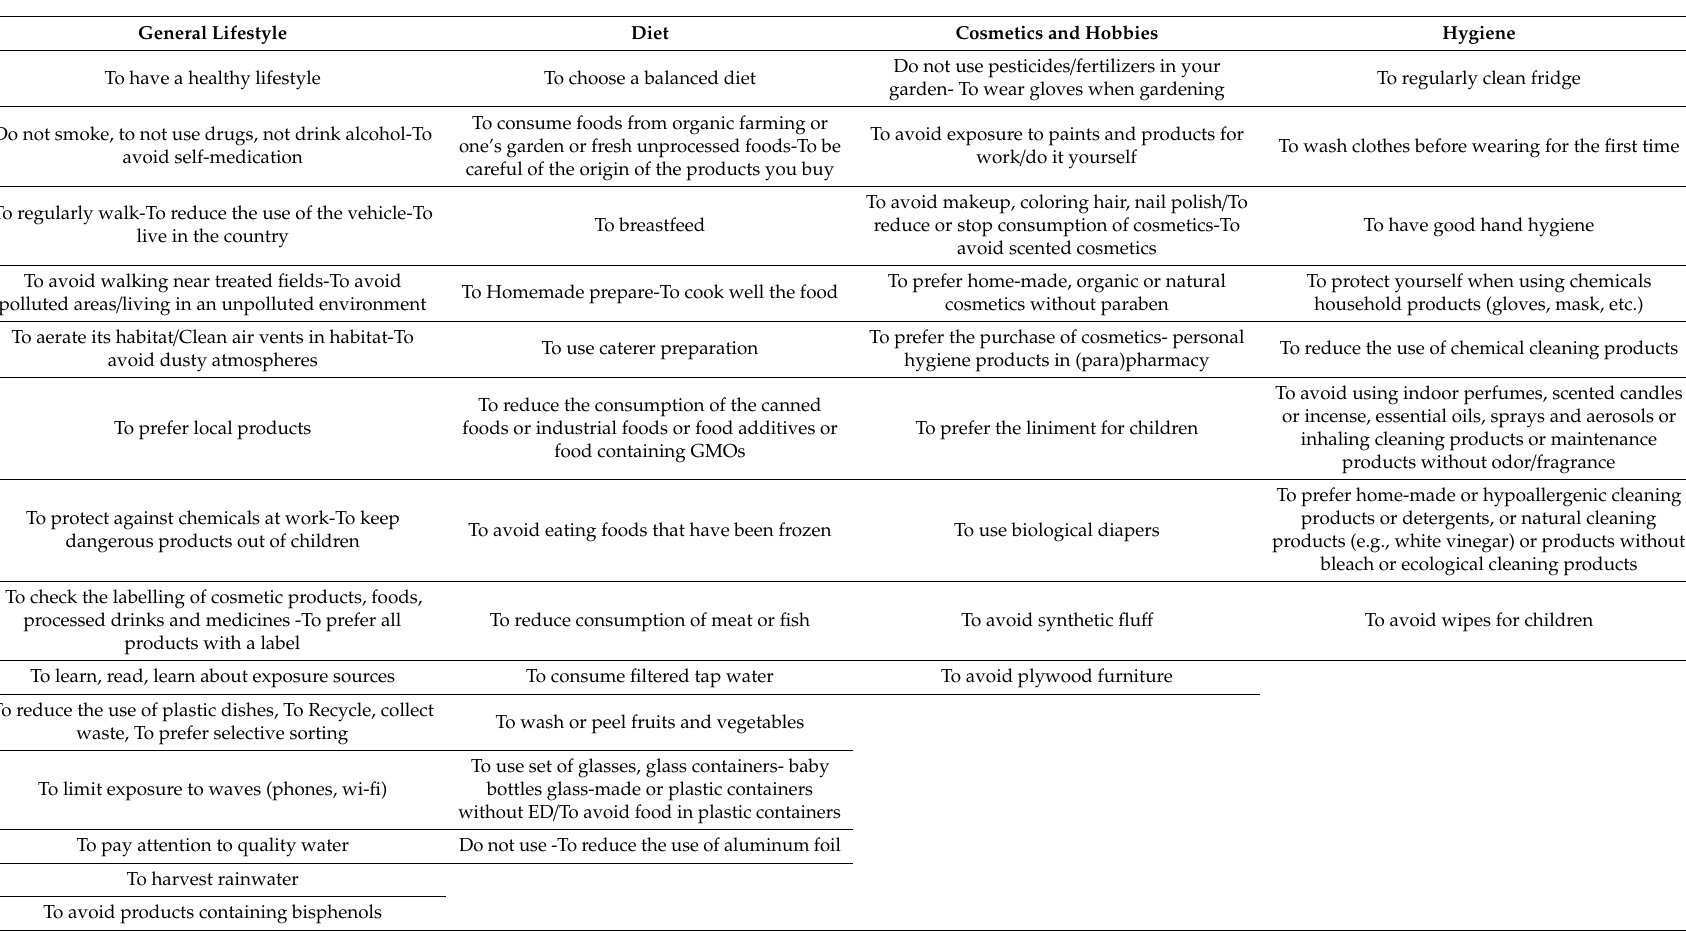
Table 5. Solutions proposed by pregnant women when was asked “how could you act to reduce endocrine disruptors?” (open